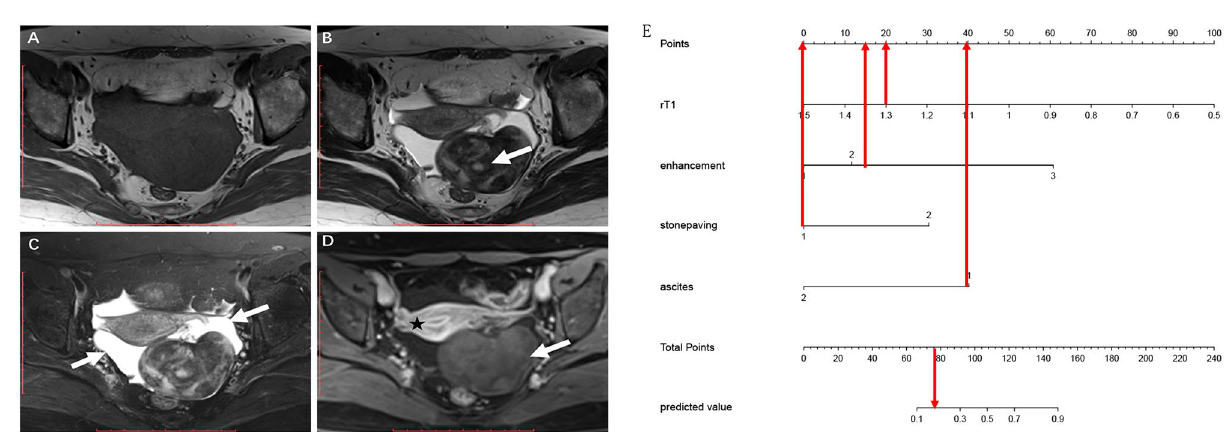
Figure 3. ( A ) The nomogram is based on Model 3, incorporating the quantitative and qualitative MRI signature. When using the nomogram, specific factors were located according to its measurements, and then a line straight up to the points axis was drawn to get the factor’s score. A total of points was obtained by summing the scores of all the involved factors. Finally, the probability of BLM was determined by drawing a line straight down to the bottom axis. ( B ) Calibration curves for the nomogram. The y-axis represents BLM’s actual rate in the patients; the x-axis represents the nomogram-predicted probability of BLM. Hosmer–Lemeshow test showed that the nomogram’s predicted efficiency is in good agreement with the actual condition (X2 = 6.855, p = 0.552 > 0.05). ( C ) Decision curve analysis (DCA) showed that the nomogram had a high net benefit in a wide range of threshold levels.